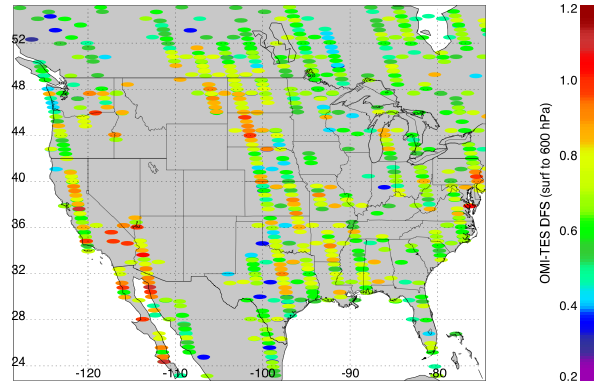
Figure 3. TES-OMI sensitivity to lower tropospheric O3, given by the trace of the AK for the Fig. 3. TES-OMI sensitivity to lower tropospheric O 3 , given by the lowest 5 layers. Only land scenes with surface pressure > 900 hPa are included; each oval represents a single observation. trace of the AK for the lowest 5 layers. Only land scenes with sur- face pressure > 900hPa are included; each oval represents a single